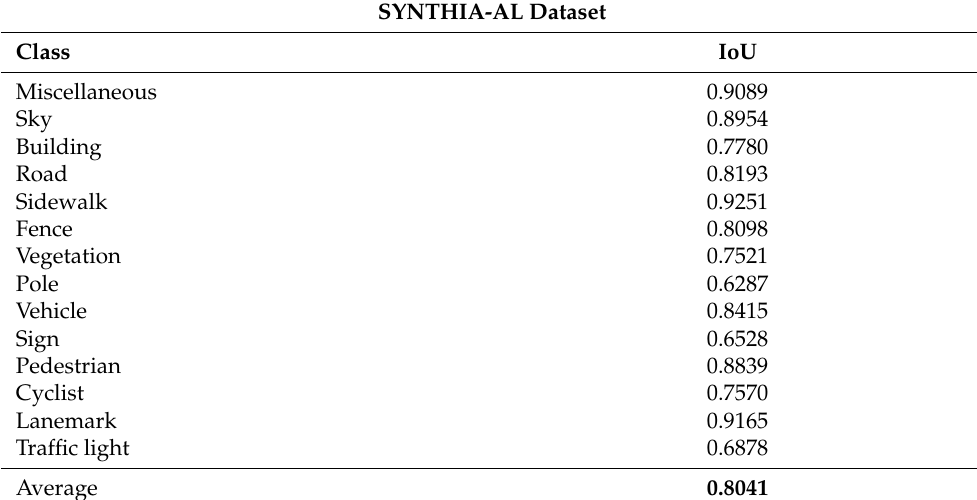
Figure 10. Results obtained with the U-Net model. Table 1. Semantic segmentation IoU (Intersection over Union) obtained for each